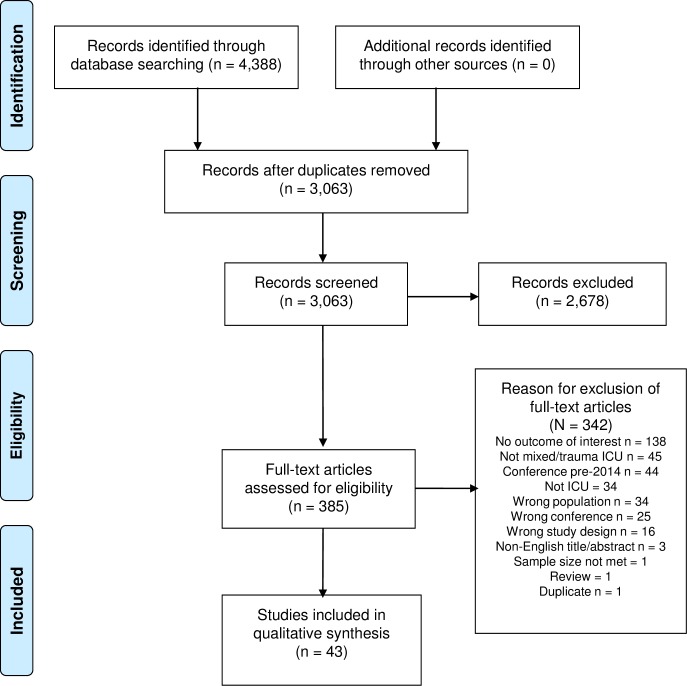
Flow of studies in the systematic scoping review and reasons for exclusion.